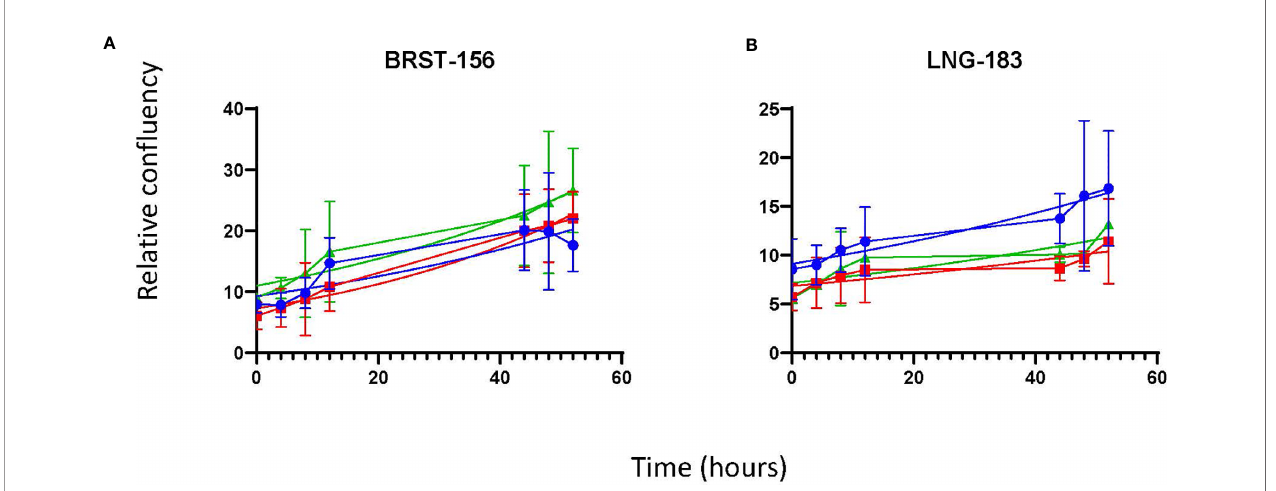
FIGURE 4 | The growth curves for non-MPM cell cultures in vitro , seeded directly in pleural fl uid. The curves show the mean and 95% con fi dence intervals, and a trendline for non-linear fi t. Cells cultures: (A) BRST-156 (breast carcinoma) , and (B) LNG-183 (lung adenocarcinoma). HF, heart failure; MPE, malignant pleural effusion.